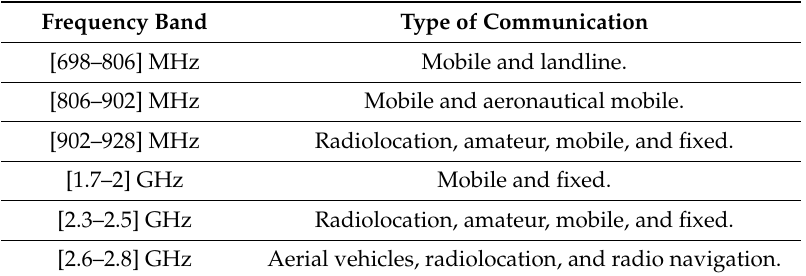
Figure 20. Percentage of occupation for a week in the frequency interval [0.6–2.6] GHz. Table 3. Monitored frequency Table 3. Monitored frequency bands.